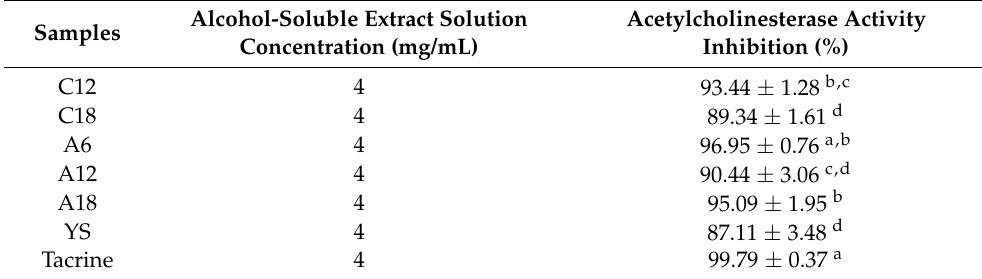
Table 5. The inhibition rates of acetylcholinesterase activity in all five batches and controls. Samples